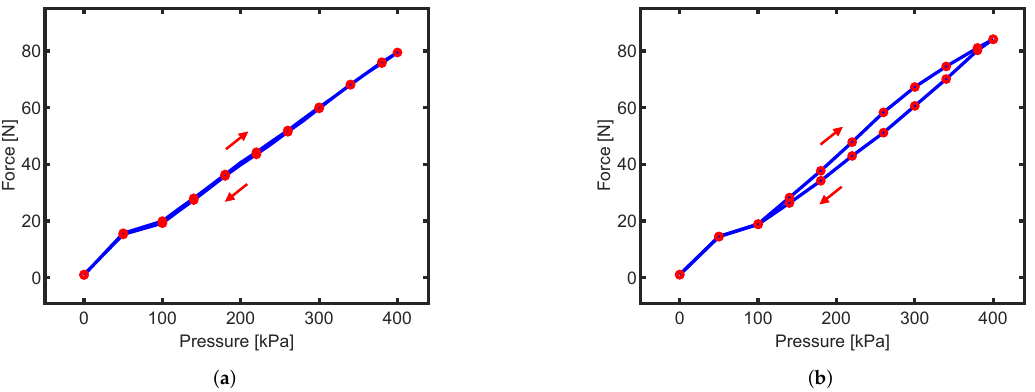
Figure 10. Isometric tests. Hysteresis cycles for ( a ) soft actuator alone and ( b ) hybrid